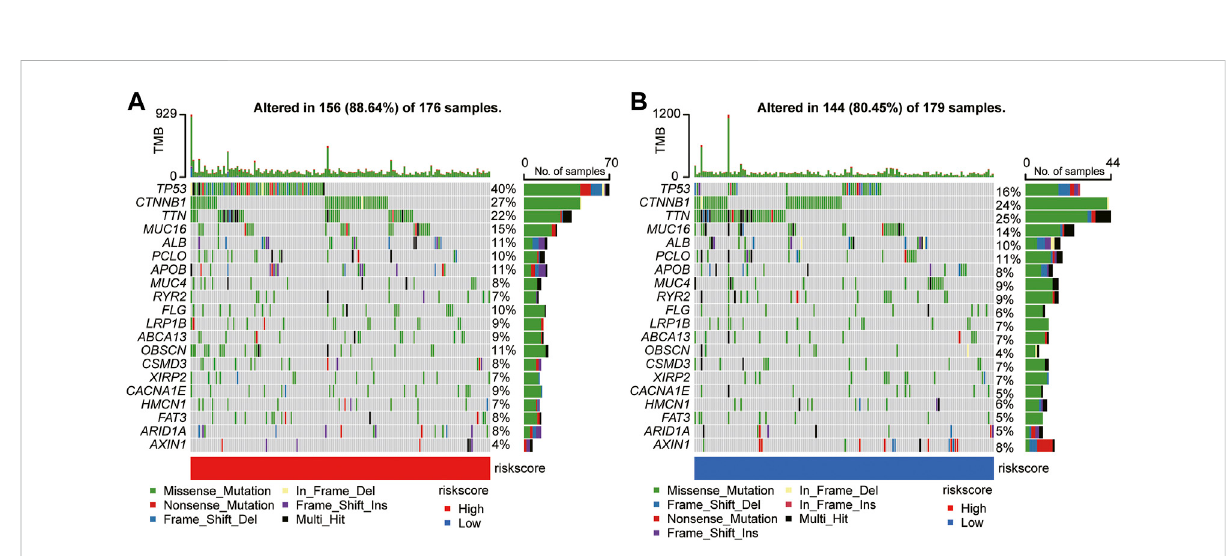
FIGURE 8 Mutational landscape of signi fi cantly mutated genes in the high-risk (A) versus low-risk (B) subgroups.